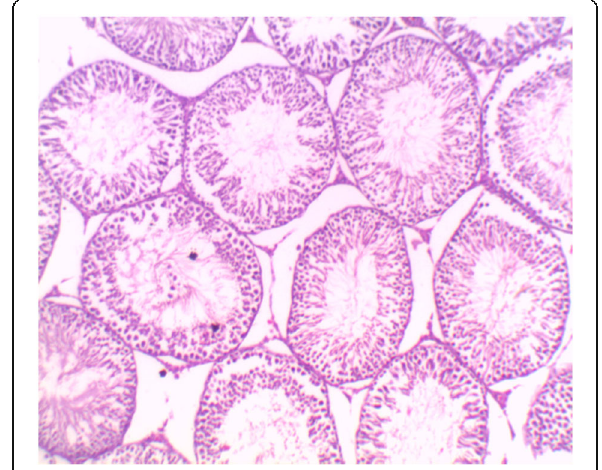
Fig. 23 Photomicrograph of CCl4-treated testis sections showing